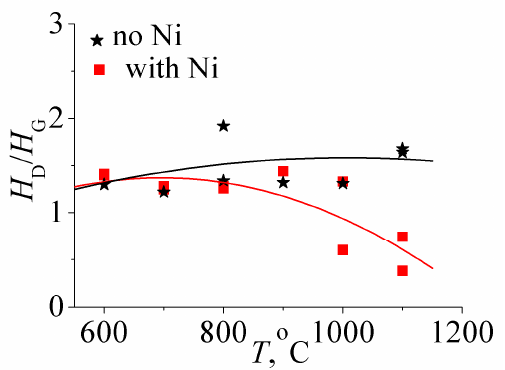
Figure 9. Temperature dependence of D and G peak height ratio H D / H G for nickel-containing and control samples.